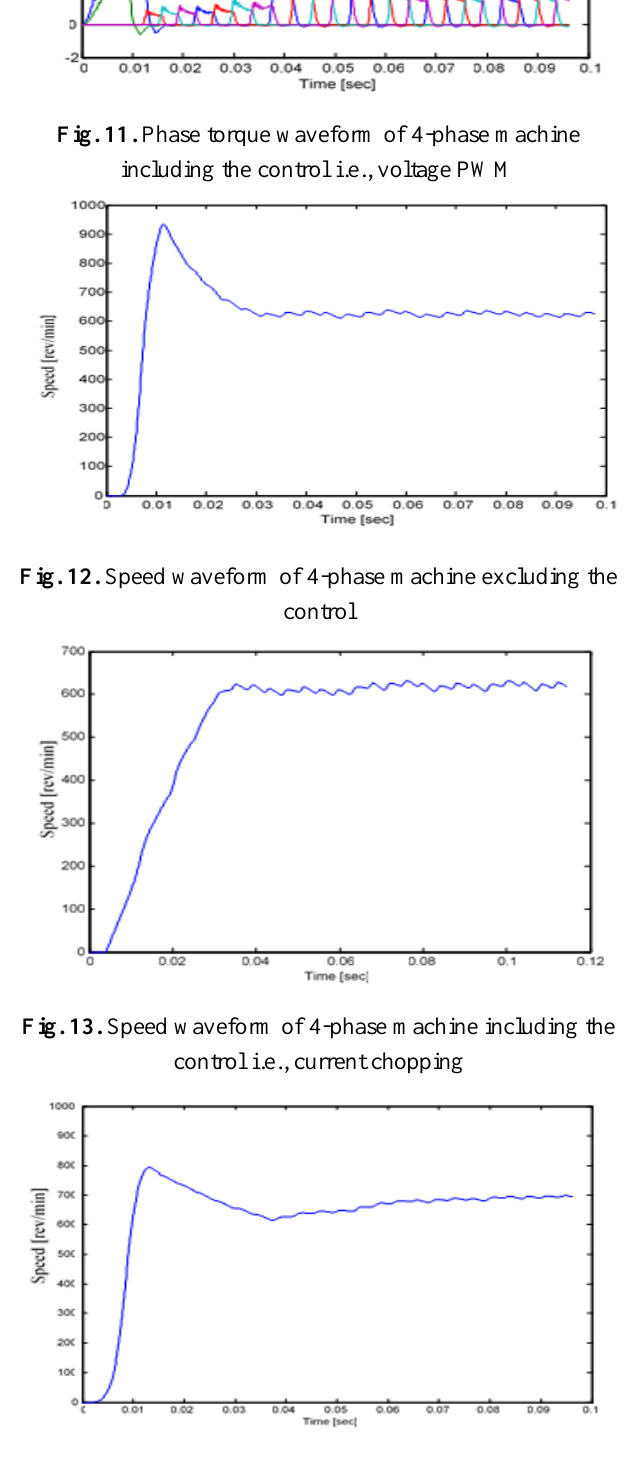
Fig. 14. Phase current waveform of 4-phase machine including the control i.e., voltage